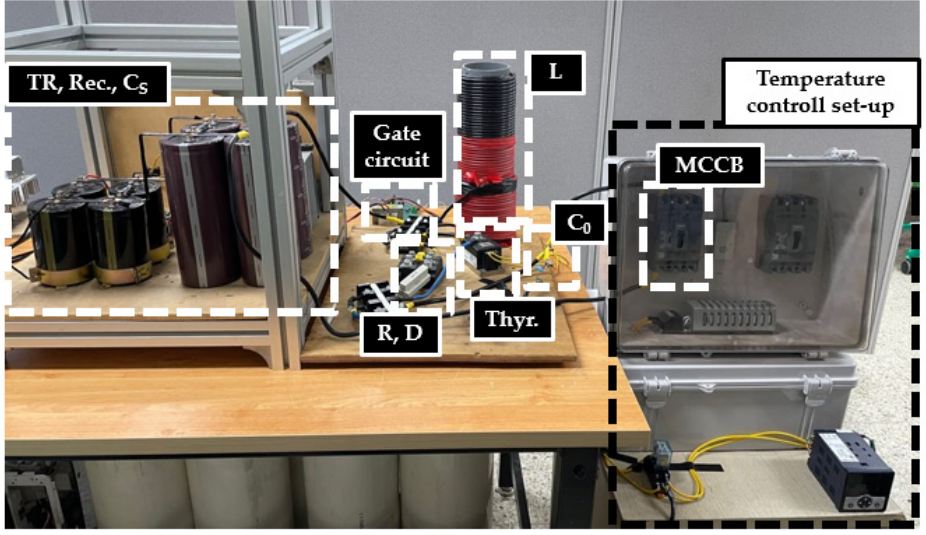
Figure 5. Test setup for temperature experiment.